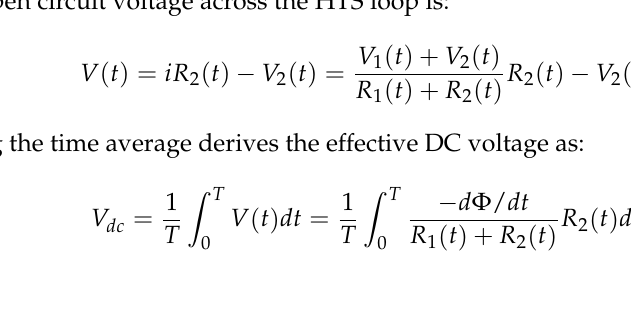
Figure 7. Electric circuit for analyzing the voltage generation.